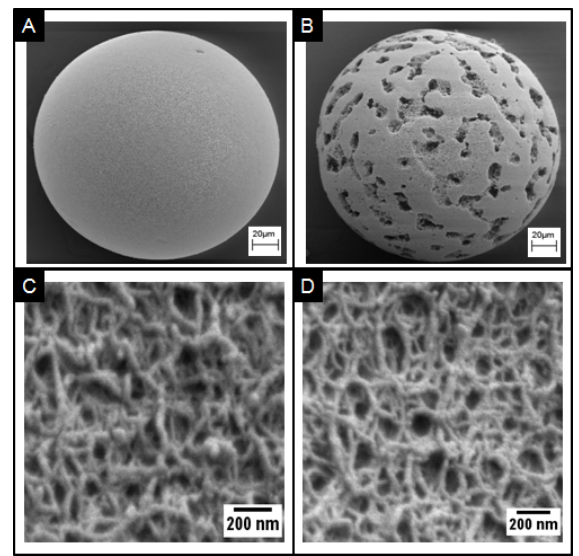
Figure 6. SEM images comparing porous agarose beads. ( A ) SEM images showing the surface morphology of homogenous beads containing 4% agarose and ( B ) superporous beads containing 4% agarose with ~30 µm microcavities that allow for rapid access of fluids in the interior matrix of the bead. ( C ) Corresponding SEM images of fibrous networks for homogenous bead and ( D ) superporous